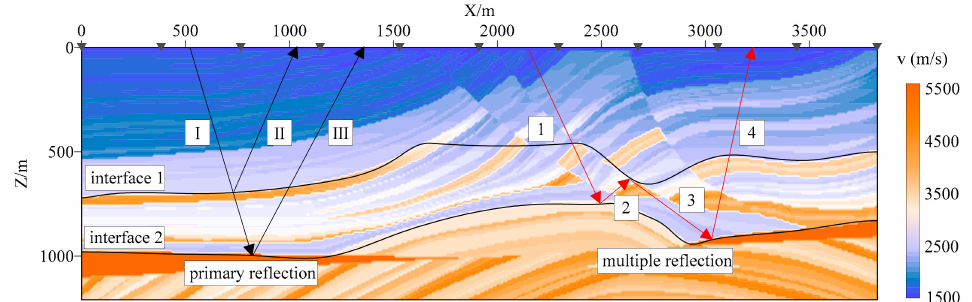
Figure 11. Marmousi model parameters and the stages of the reflection waves. The gray inverted triangle (cid:72) represents the receiving points, the black and red arrows represent the raypaths of the primary and multiple reflection waves, respectively. I, II, III represent the the first, second and third computation stage of the primary reflection waves, and 1, 2, 3, 4 represent the first, second, third and fourth computation stage of the multiple reflection waves.